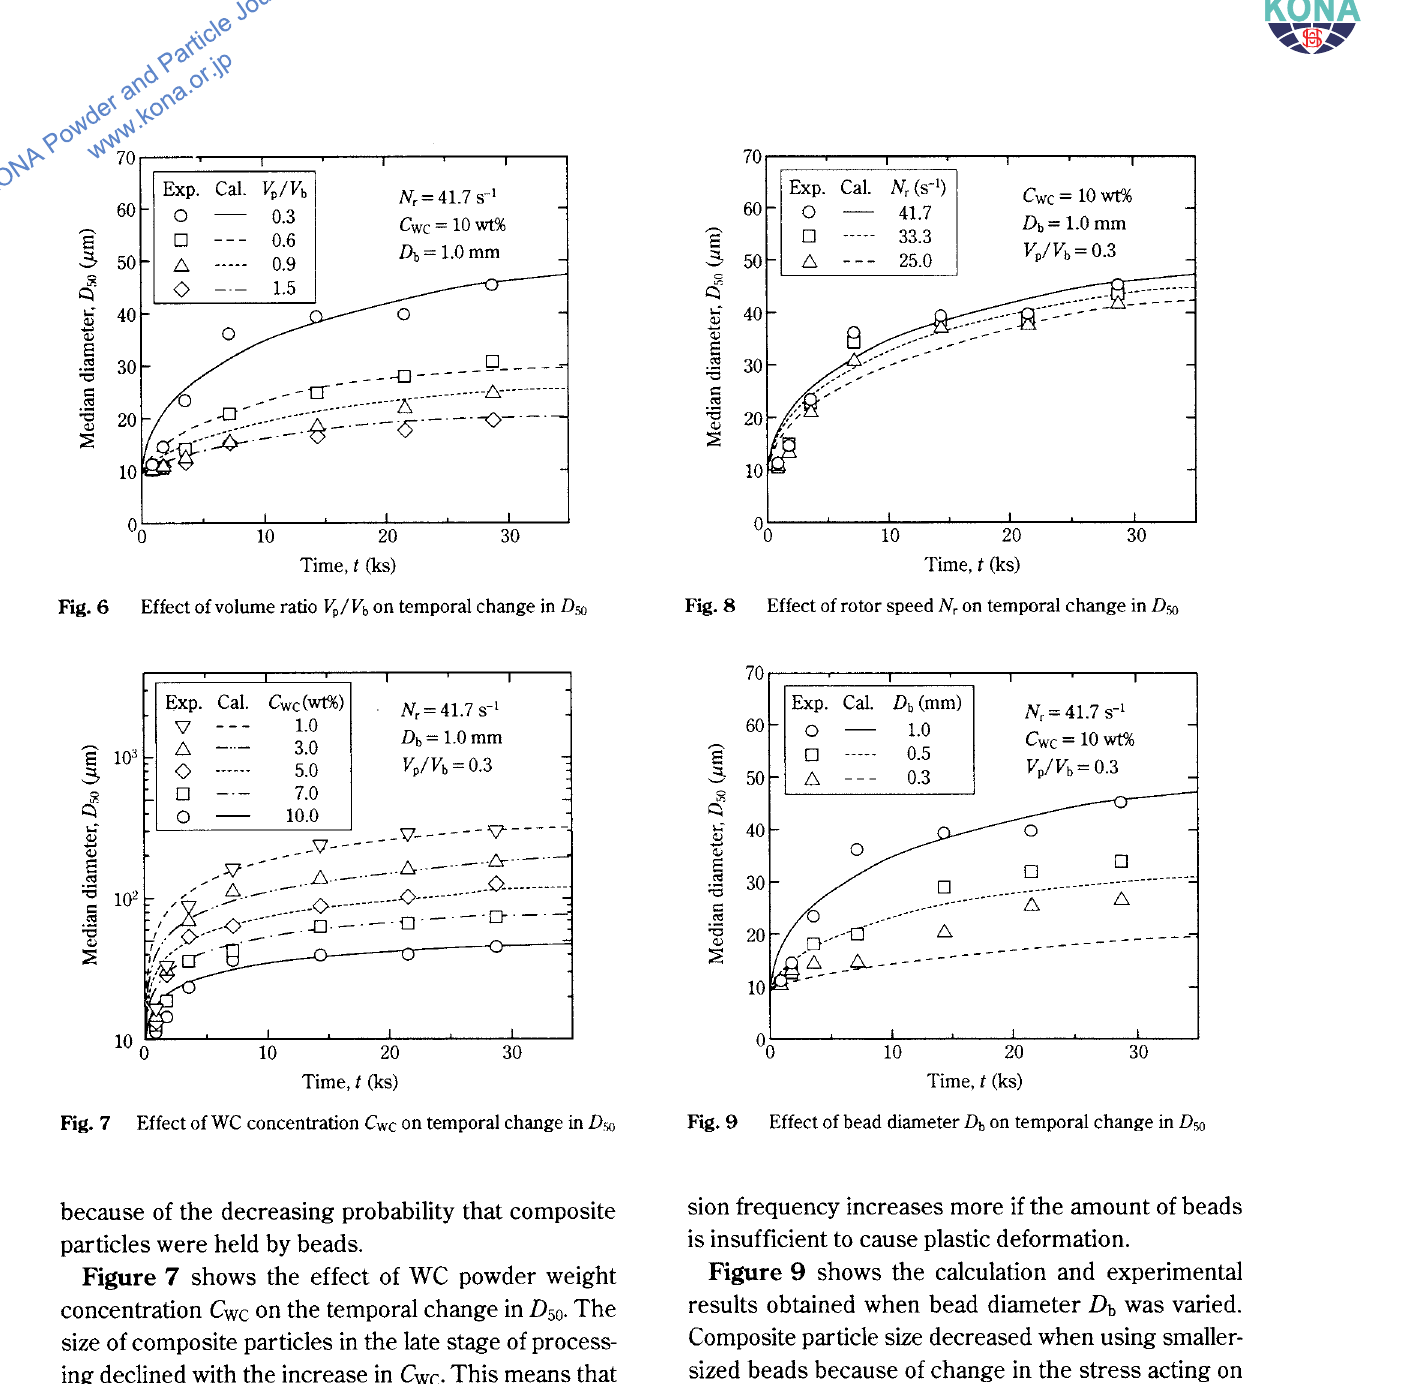
sion frequency increases more if the amount of beads is insufficient to cause plastic deformation. Figure 9 shows the calculation and experimental results obtained when bead diameter Db was